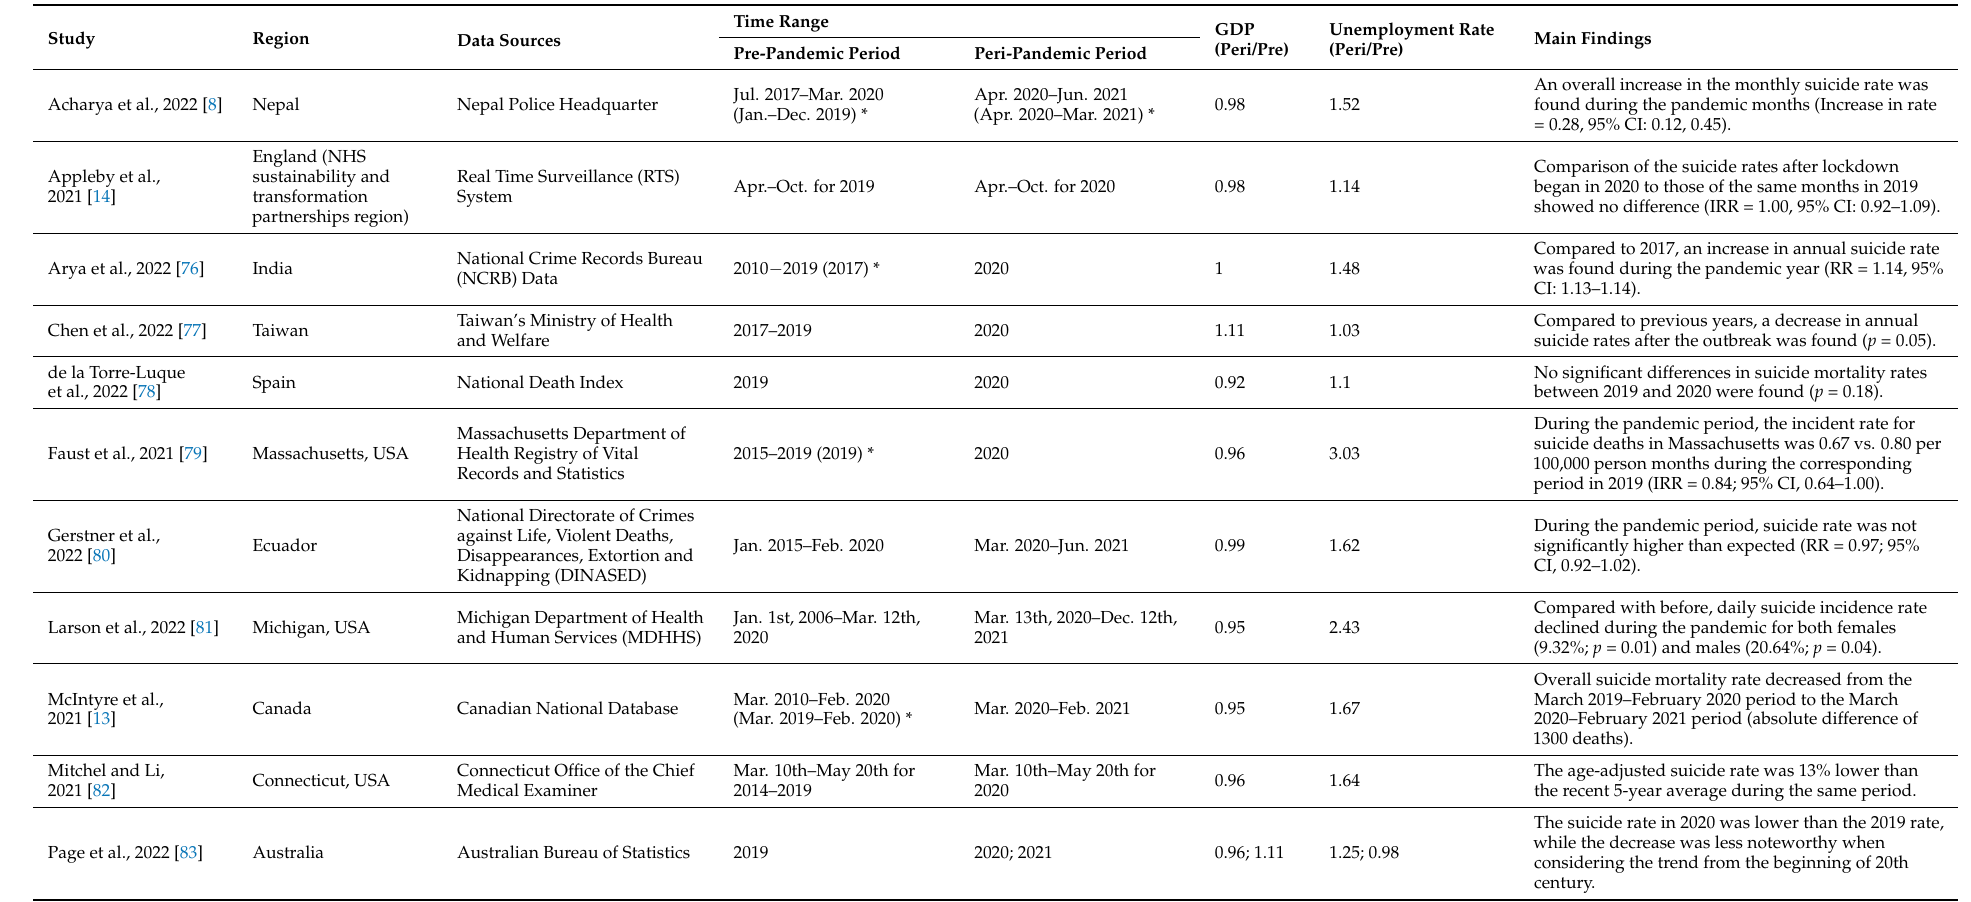
Table 2. Characteristics of studies reporting death by